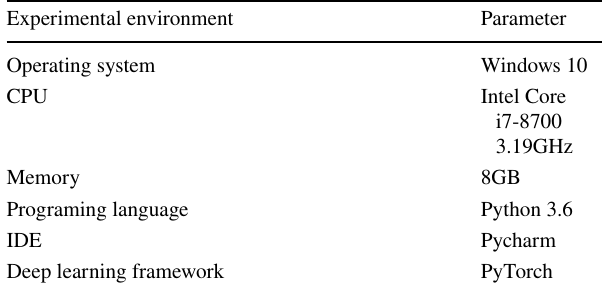
Table 6 Experimental environment and parameters Experimental environment